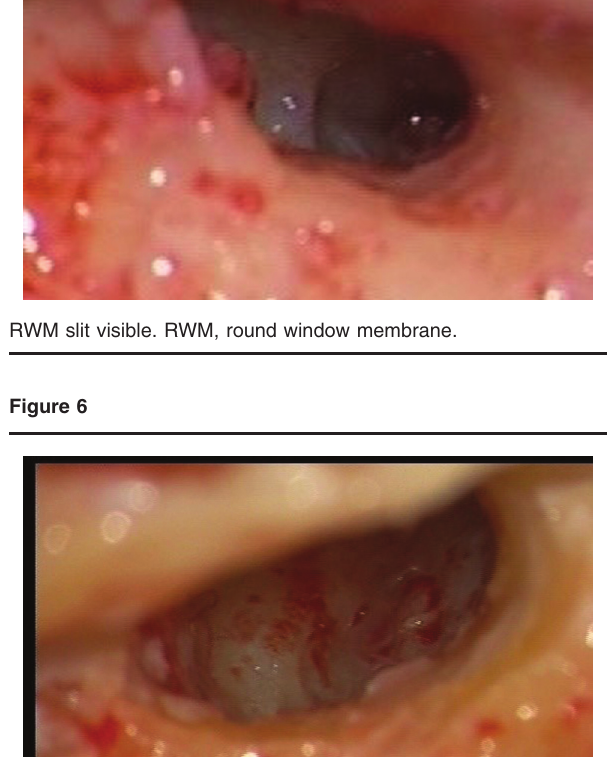
RWM nonvisible. RWM, round window membrane.